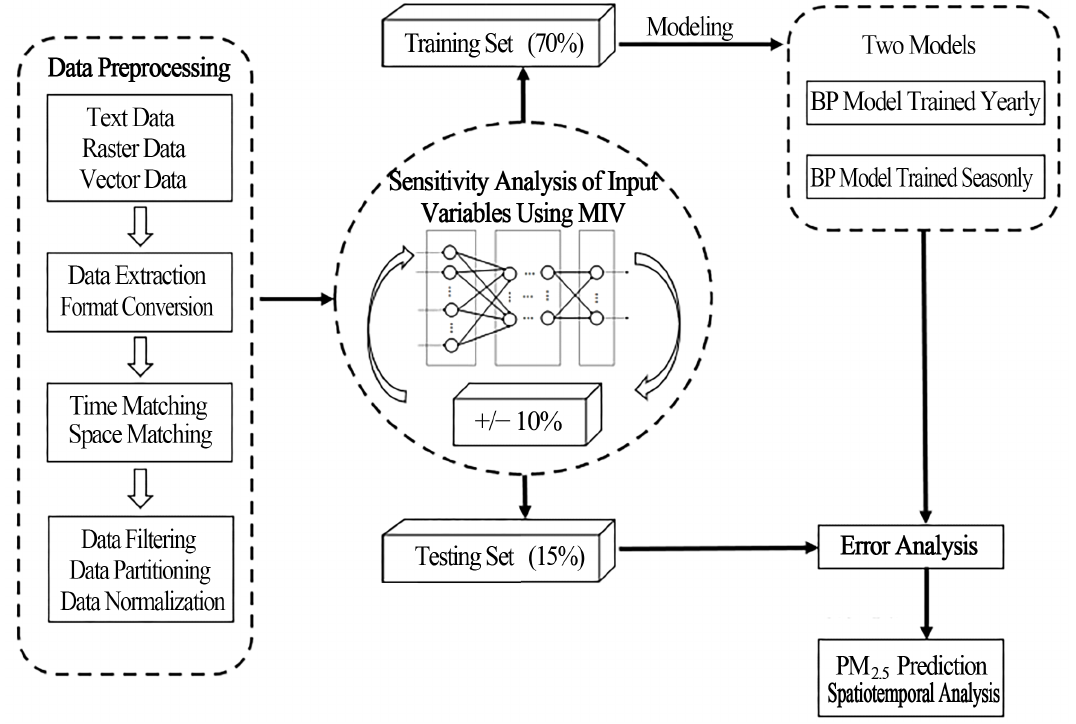
Figure 2. Modeling flow.